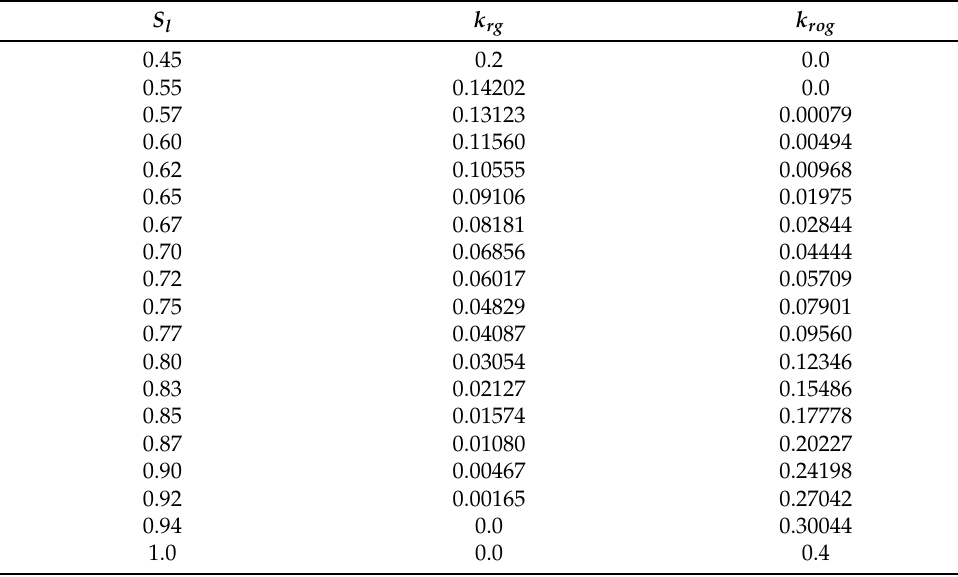
Table 2. Liquid–gas relative permeability for Example 1.